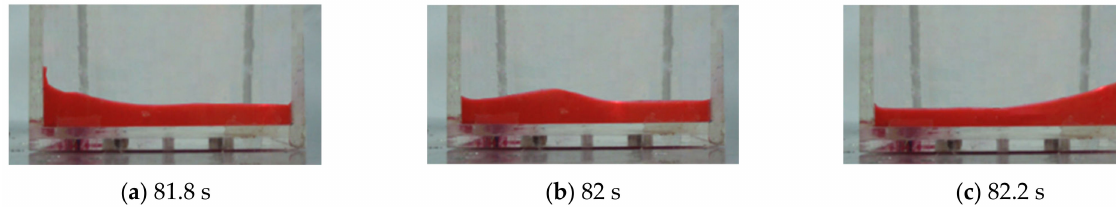
Figure 16. Still shots of a first natural frequency wave recorded by the video camera.